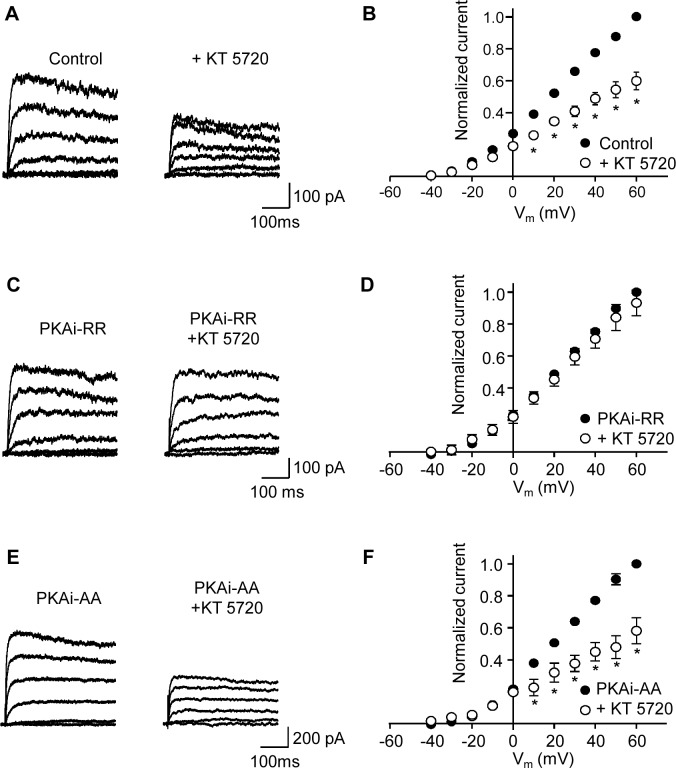
Inhibition of PKA attenuates Kv current.Kv currents were activated in response to 400 ms depolarizing voltage steps from a holding potential of -65 mV. (A) Representative Kv current traces before (control) and after application of 1 μM KT 5720 as indicated. Representative Kv currents shown in this and subsequent figures are in 20 mV increments beginning from -40 mV. (B) Mean (± s.e.m.) I-V plots (normalized to control current at +60 mV) before and after application of 1 μM KT 5720 (n = 8 cells). (C) Representative Kv current traces before and after application of 1 μM KT 5720 obtained in the presence of the PKA inhibitor peptide, PKAi-RR (5 μM) in the patch pipette. (D) Mean (± s.e.m.) I-V plots (normalized to the control currents, i.e. in the presence of PKAi-RR, at +60 mV) before and after application of 1 μM KT 5720 as indicated (n = 5). (E) Representative Kv current traces before and after application of 1 μM KT 5720 in the presence of PKAi-AA (5 μM), an inactive isoform of PKAi-RR, in the patch pipette. (F) Mean (± s.e.m.) I-V plots (normalized to the respective control currents, i.e. in the presence of PKAi-AA at +60 mV) before and after application of 1 μM KT 5720 as indicated (n = 7). *P<0.05; two-way ANOVA, Bonferroni’s post hoc test.